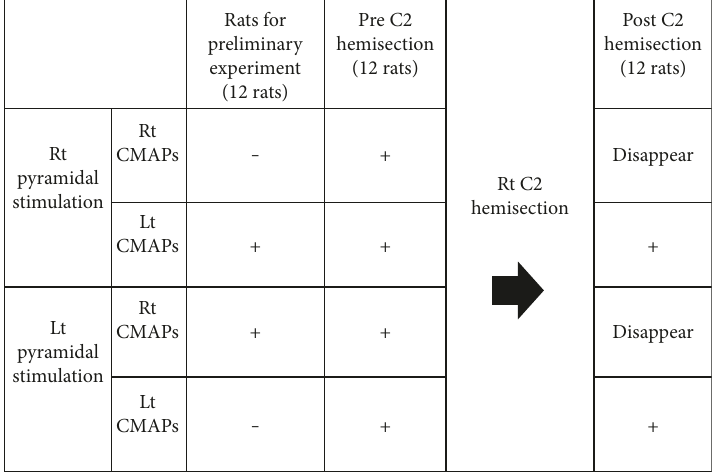
Figure 10: Summary of the results of this experiment. All the rats in the group for the preliminary experiment (those that later received the left C5 segmental hemisection) exhibited contralateral electrical activity in response to the stimulation on one side. Also, at 6 weeks after the C5 hemisection surgery, all 12 rats exhibited CMAPs from both forelimb muscles in response to the stimulation on one side before the additional C2 hemisection. With the rats that received the additional C2 hemisection, only the electric potential on the right side was lost. CAMPs: compound muscle action potentials; Rt: right; Lt: